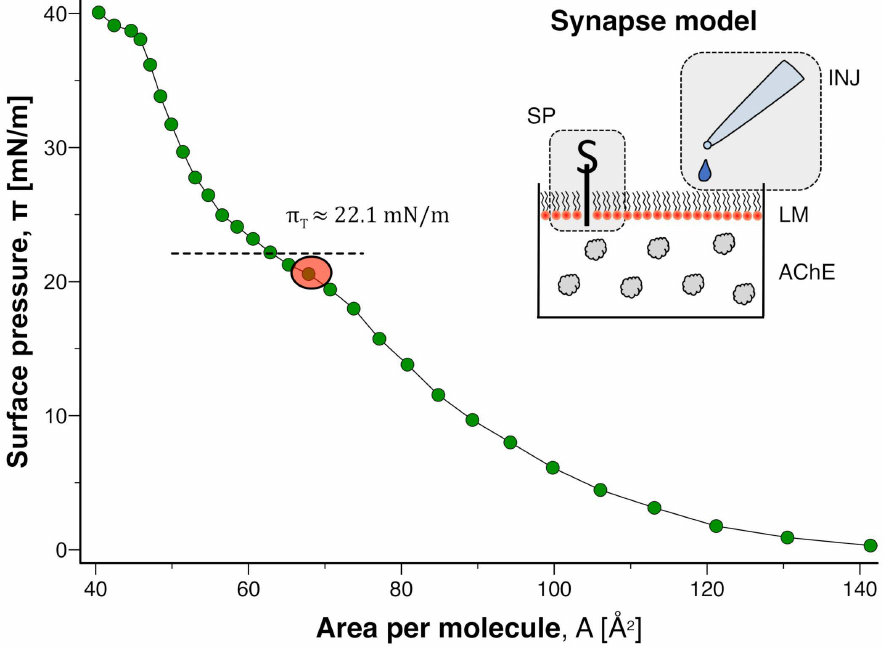
Figure 1. Isothermal state diagram of DMPS monolayer on standard subphase (100 mM NaCl, 0.5 mM phosphate buffer, pH set to 7.0 at T ≈ 23.0 ◦ C). (dashed horizontal line) Transition pressure π T . (red circle) Initial states for injection experiments. Data series is a representative example taken from a set of n = 4 measurements. (inset) The setup is a simple model of a cholinergic synapse. Substances can be injected (INJ) in vicinity of a lipid membrane (LM) whose state is monitored with a surface pressure sensor (SP) . The subphase contains acetylcholinesterase (AChE)